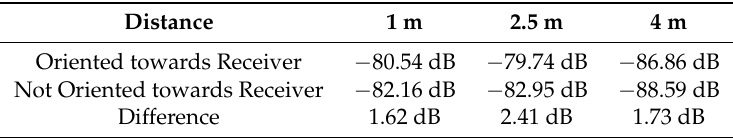
Table 6. RSSI measurements depending on the antenna direction.